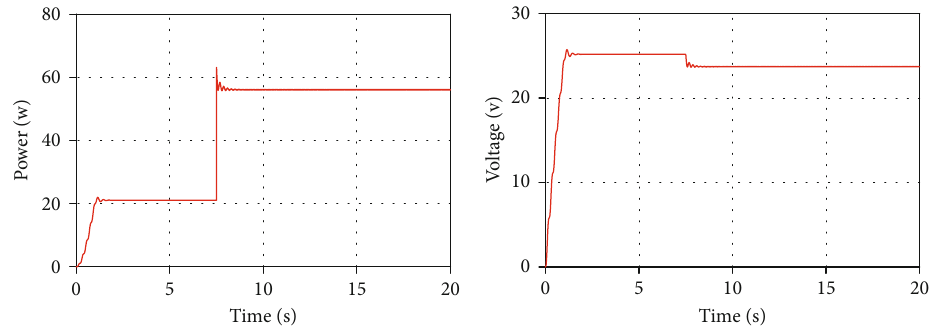
Figure 15: Load power and load voltage under load